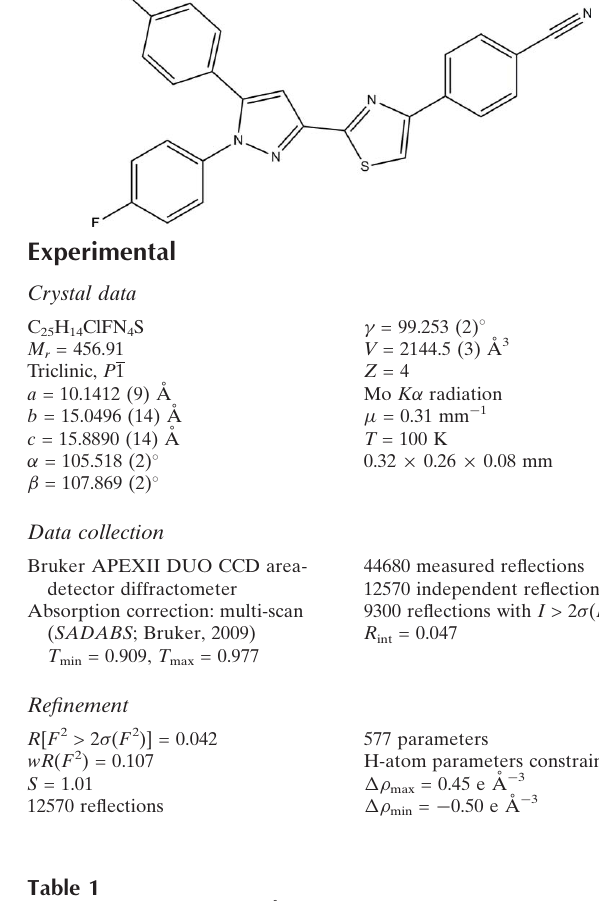
Hydrogen-bond geometry (A˚ , (cid:2) ). Cg 1 and Cg 2 are the centroids of the C1 A –C6 A and C1 B –C6 B rings,